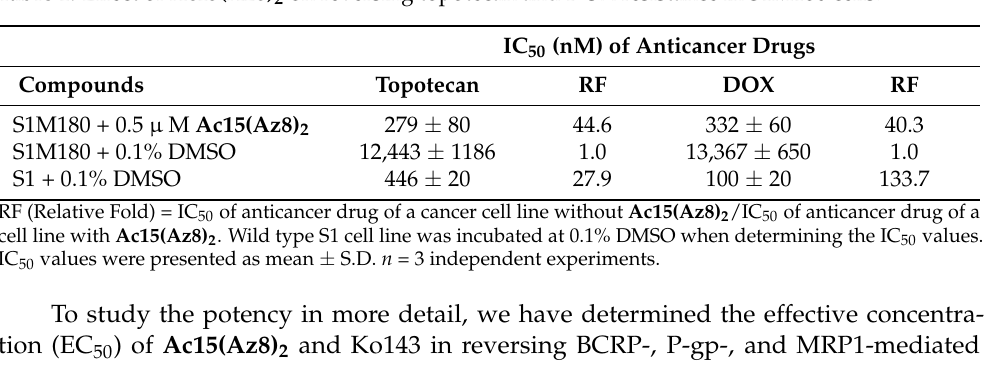
Table 1. Effect of Ac15(Az8) 2 on reversing topotecan and DOX resistance in S1M180